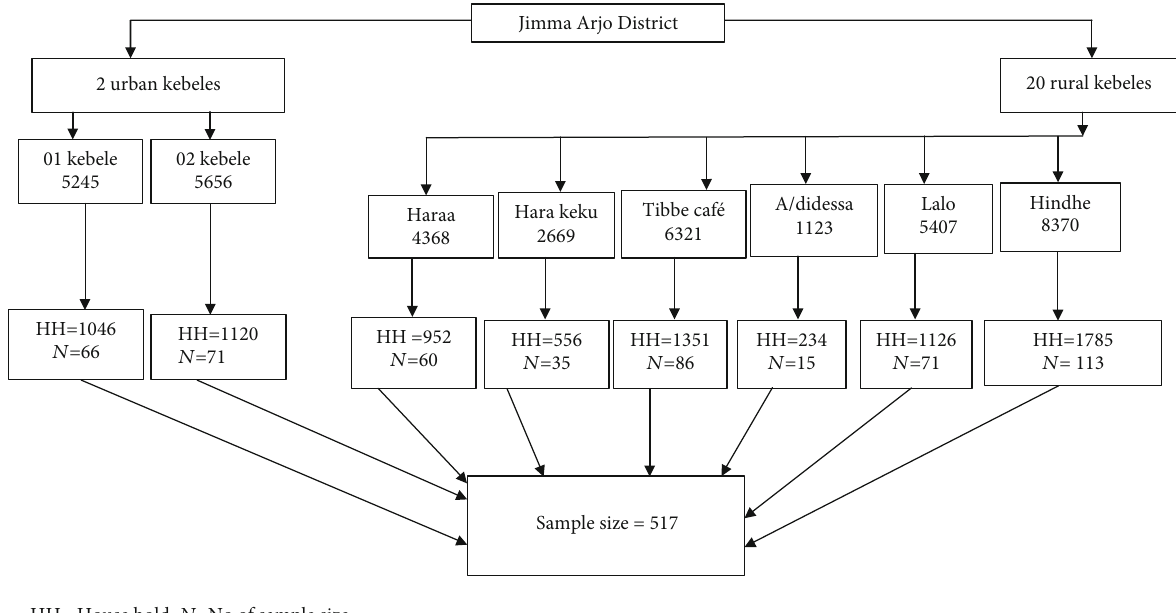
HH= House hold, N =No of sample size Figure 2: Sampling technique for assessing the determinants of maternal choice of delivery place among childbearing age women of Jimma Arjo District, Oromia, Ethiopia, 2018. HH: household, N : no. of sample